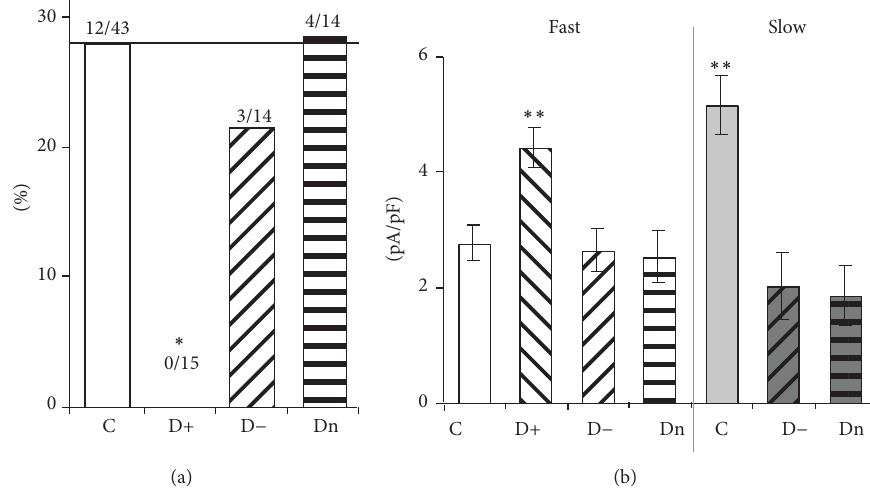
Figure 3: Functional expression of fast and slow T-currents in NTCN neurons under different PDN conditions. (a) Percentage of NTCN neurons revealing the slow T-current in control (C), hyper- (D+), hypo- (D − ), and normalgesic (Dn) groups. The slow T-current was not observed under hyperalgesic conditions, ∗ 𝑃 < 0.05 (Fisher’s exact test). The numbers above the columns indicate the number of NTCN neurons expressing the slow T-current of the total number of tested neurons in the respective group. (b) PCD of fast and slow T-currents under the control and PDN conditions. It is interesting to note that the fast T-current was upregulated in hyperalgesic conditions while the slow T-current was strongly downregulated in norm- and hypoalgesia. Each column was the mean and SEM from number of neurons specified in (a). ∗∗ 𝑃 < 0.01 (ANOVA). n.s.: not significant